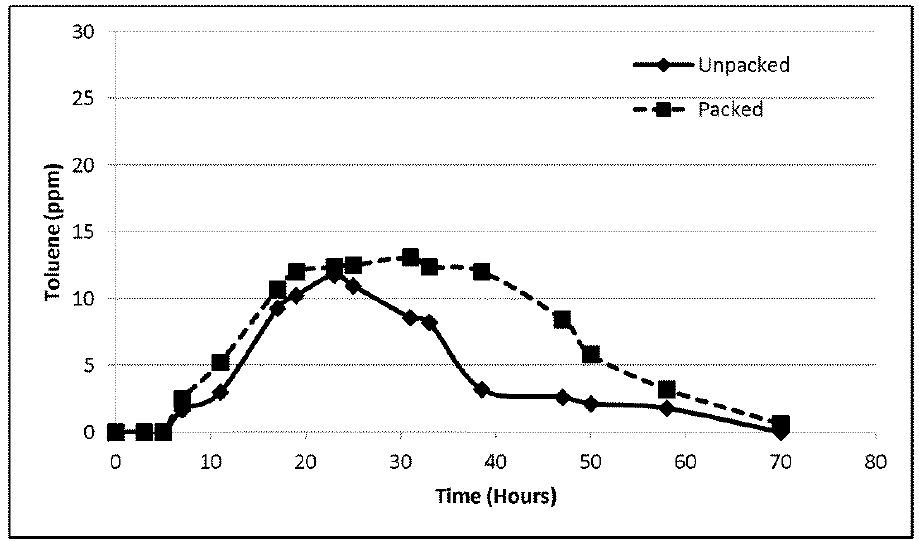
Figure 3. Toluene degradation results for unpacked system.